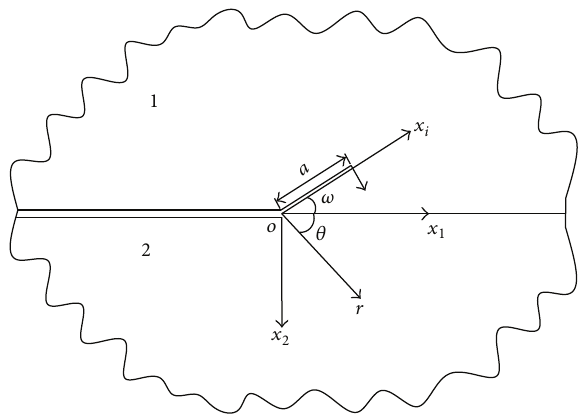
Figure 2: Geometry of a crack propagating along and kinking out of the